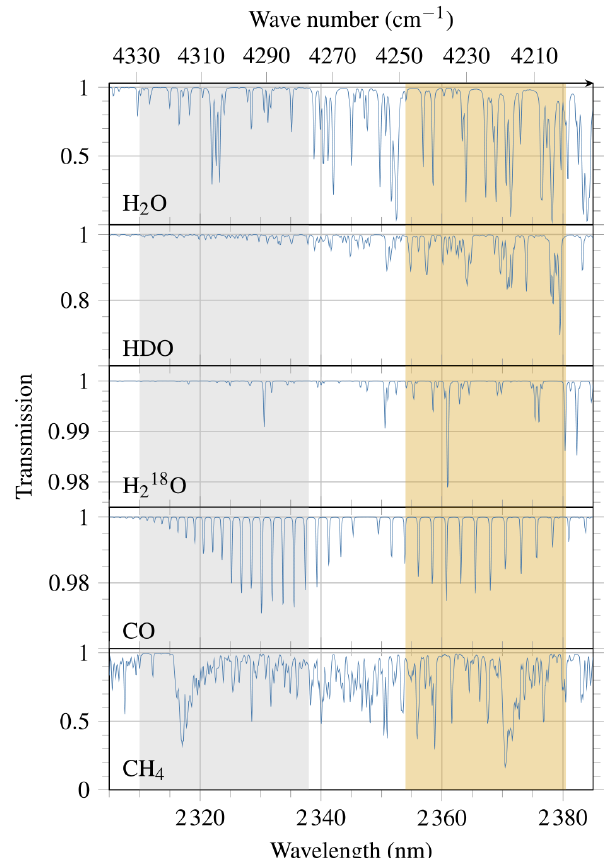
Figure 1. Simulation of atmospheric transmission in the spectral range of TROPOMI’s SWIR channel for the absorbers taken into account by the retrieval algorithm. The grey shading marks the spec- tral window used for the determination of effective cloud parame- ters, the yellow shading the spectral window for the retrieval of the trace